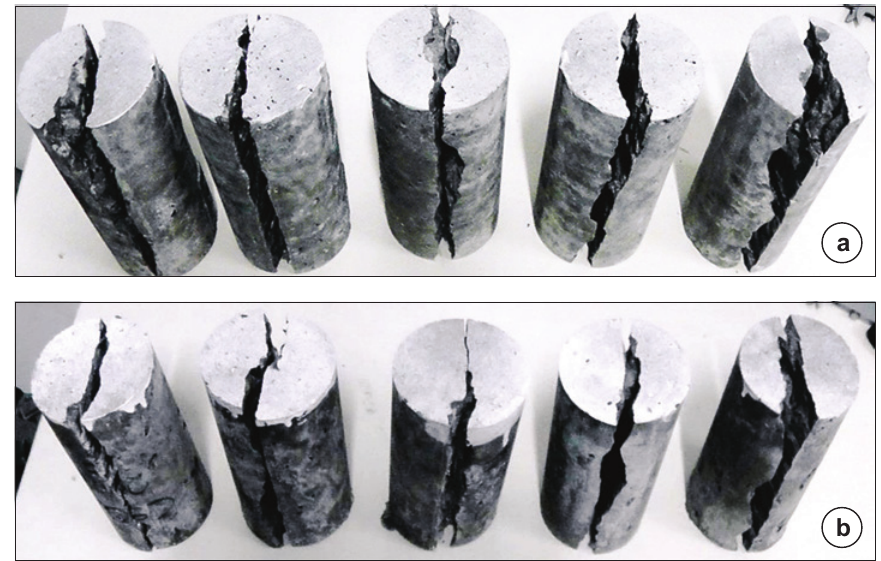
Figure 6 Failure modes of cylinders tested in diametral compression, (a) reference tests, (b) samples cast in horizontal position (see Figure 1)